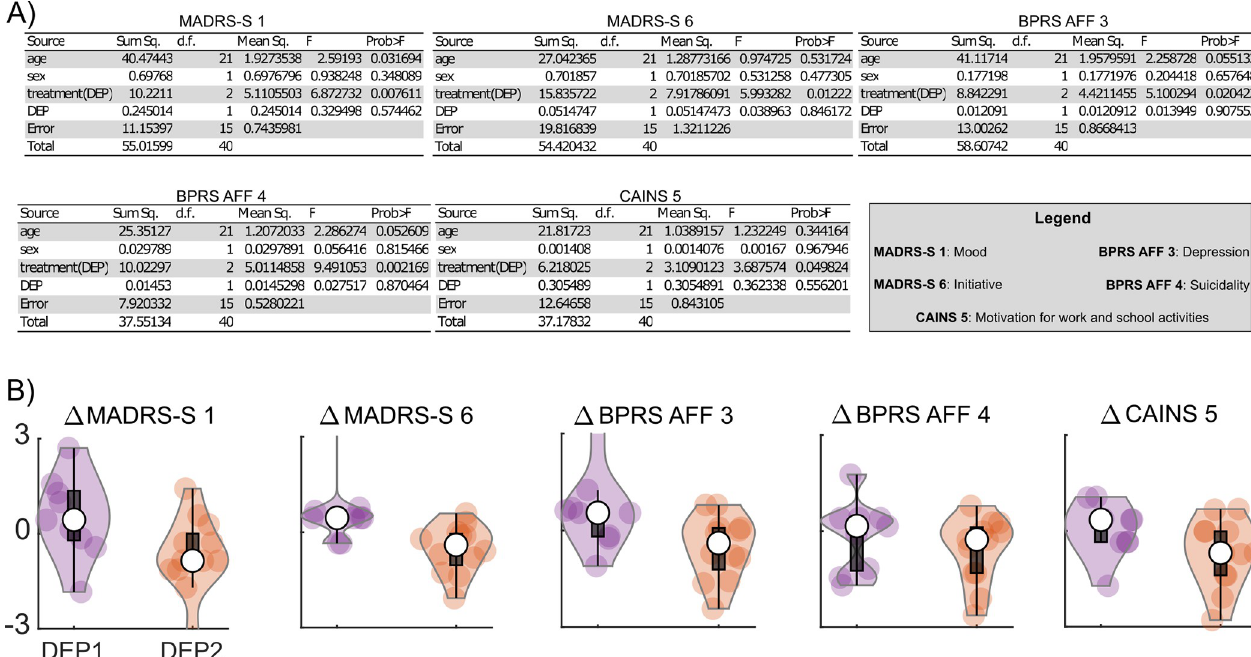
Fig 4. Treatment and depression subtypes modulate certain items of MADRS-S, BPRS AFF and CAINS. (A) The table summarizes the nested ANOVA results for MADRS-S, BPRS AFF and CAINS items. (B) Violin plots depict the distributions of the differences in MADRS-S1, MADRS-S6, BPRS AFF3, BPRS AFF4 and CAINS 5 changes (follow-up–baseline) between active treatment and the median score in the sham treatment for each depression subtype. The boxplot summarizes the statistical parameters of the distribution. The white dot represents the median, the lower and upper edges of the black box show the first and third quadrants, and the interquartile range is shown by the whiskers. The dots within the violin plot represent the individual data points.